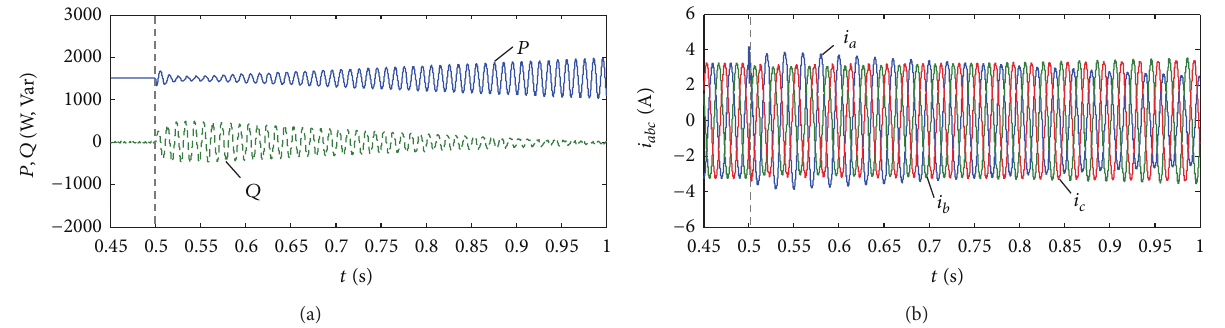
Figure 10: Sensitivity analysis of coefficient 𝛼 for power control. (a) Active and reactive power when 𝑛 = 0.2 . (b) Output current when 𝑛 = 0.2 .